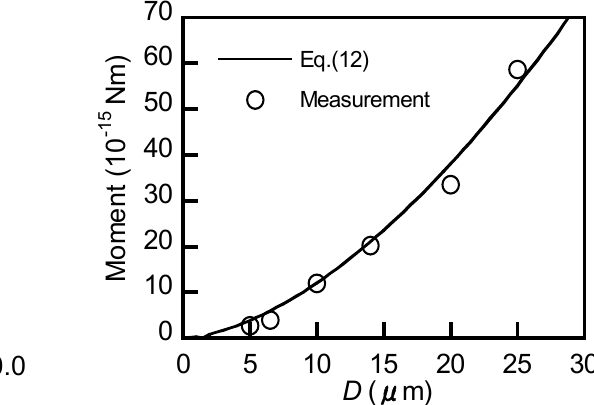
Fig. 11 Removal rate dependence on the centrifugal moment Fig. 12 Variation of adhesive moment with particle for various particle diameters